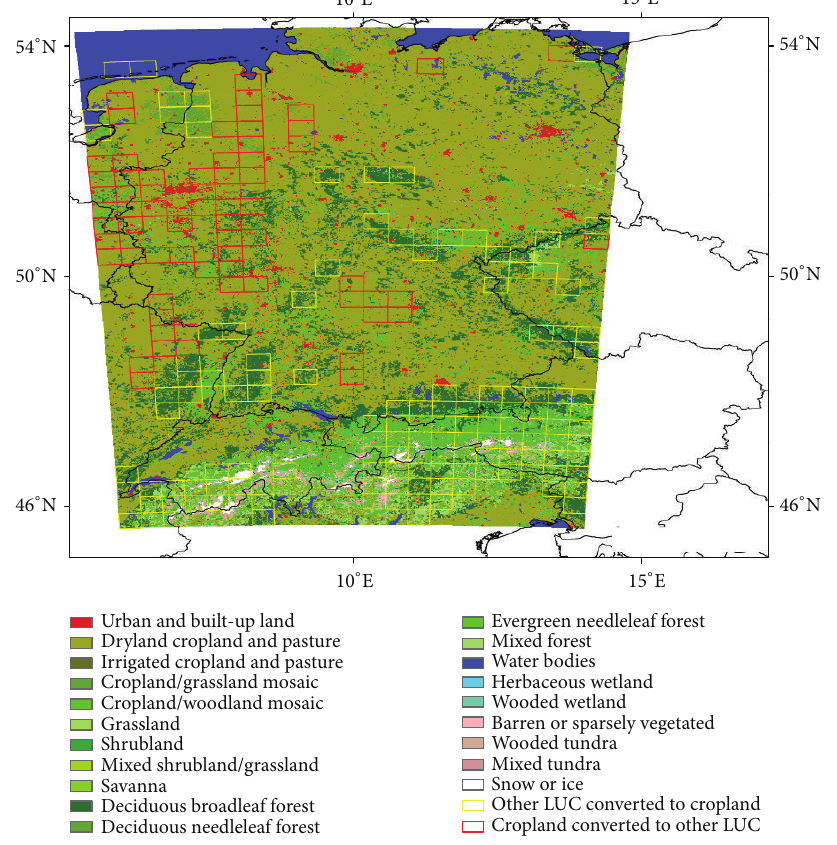
Figure 3: Major land use conversion in Central Europe, 2010–2050.